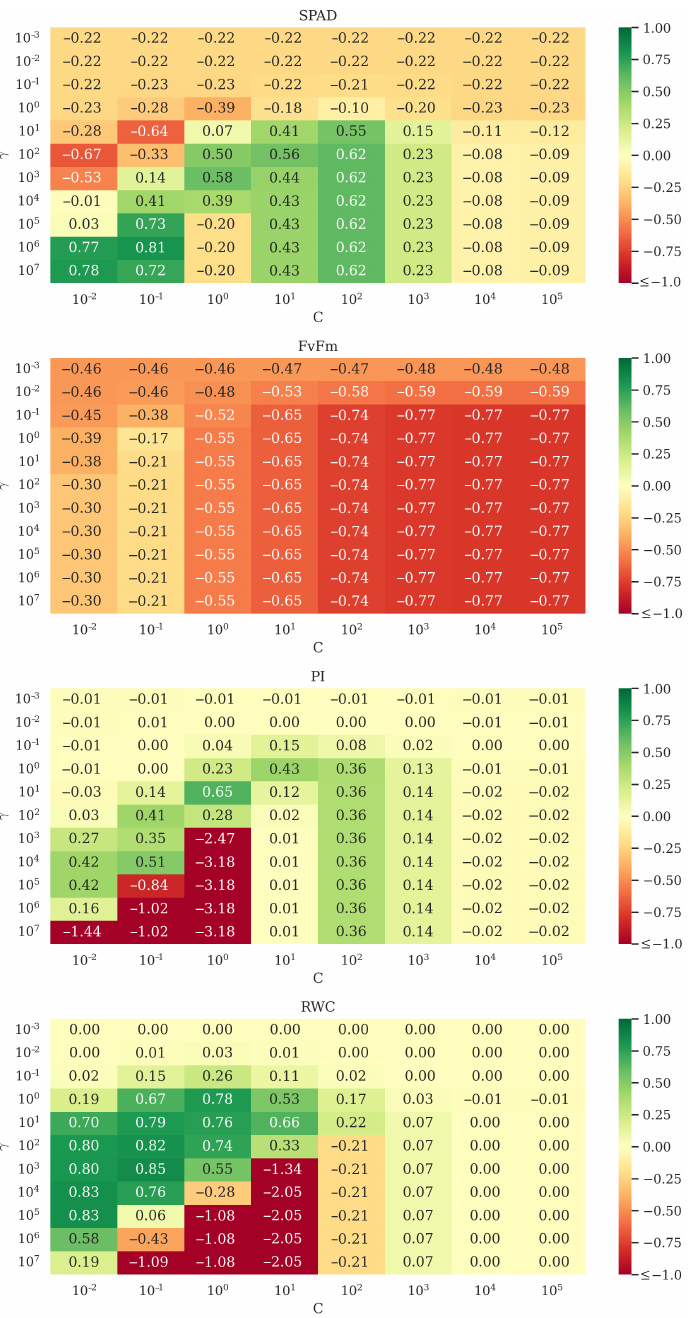
Figure 6. The results elaborated using a Support Vector Machine over the test sets for each parameter, and obtained using a range of the C and γ hyperparameter